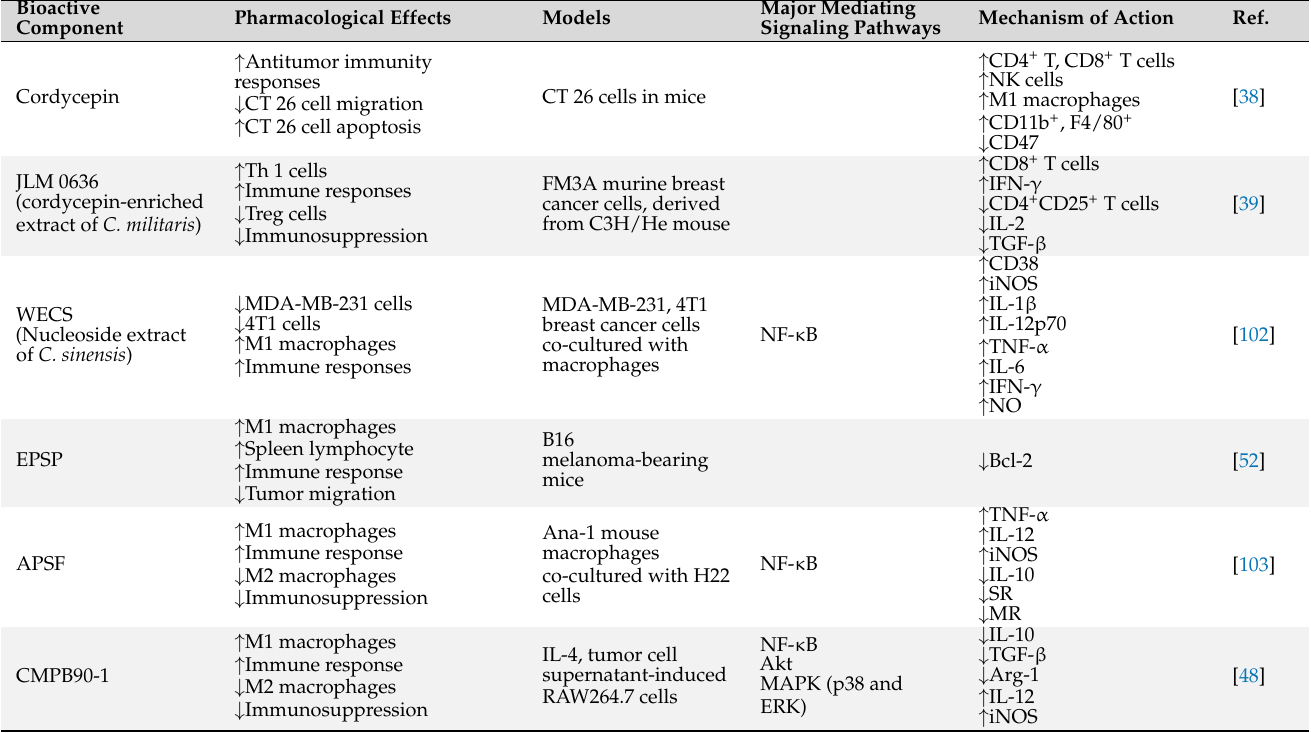
Table 3. Antitumor immunity effects and mechanisms of Chinese Cordyceps in various